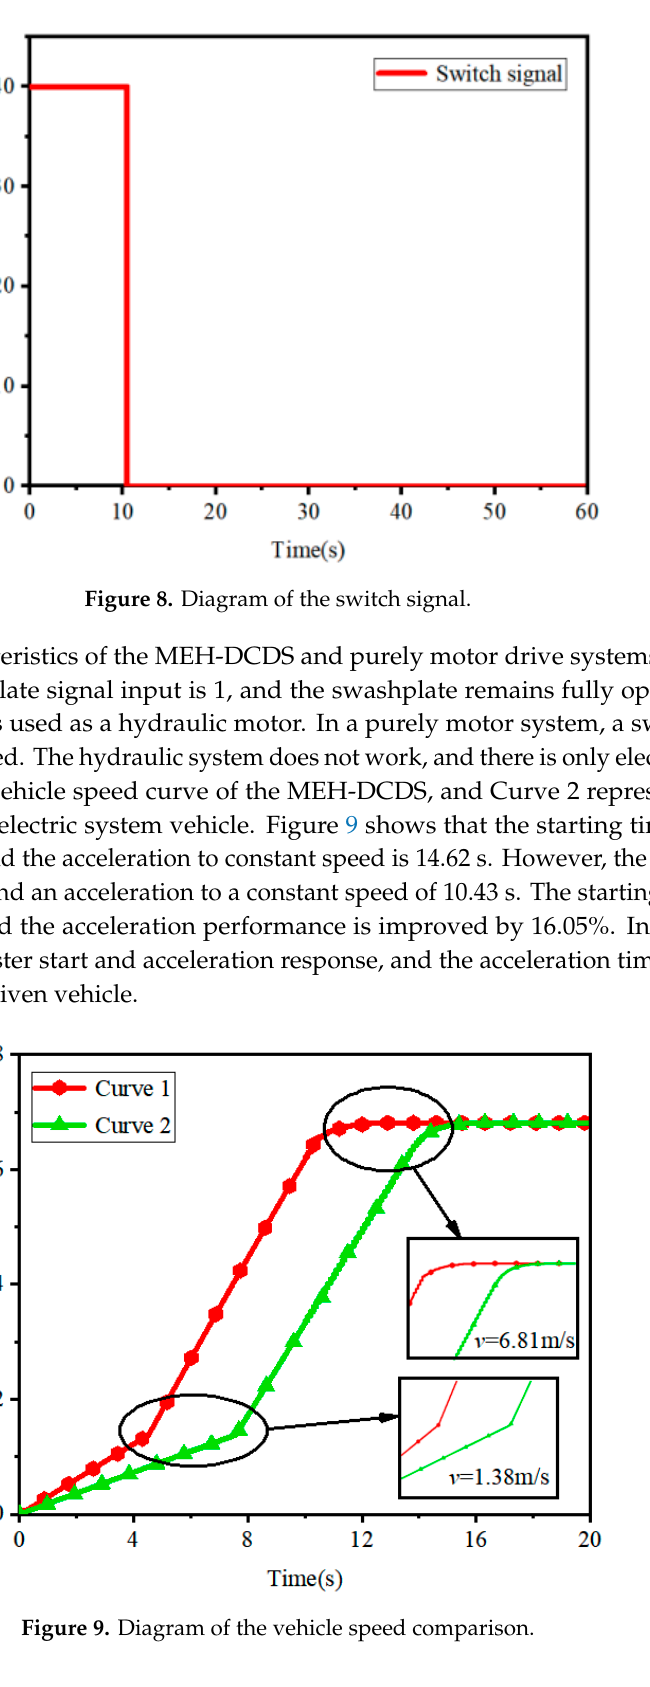
Figure 9. Diagram of the vehicle speed comparison.